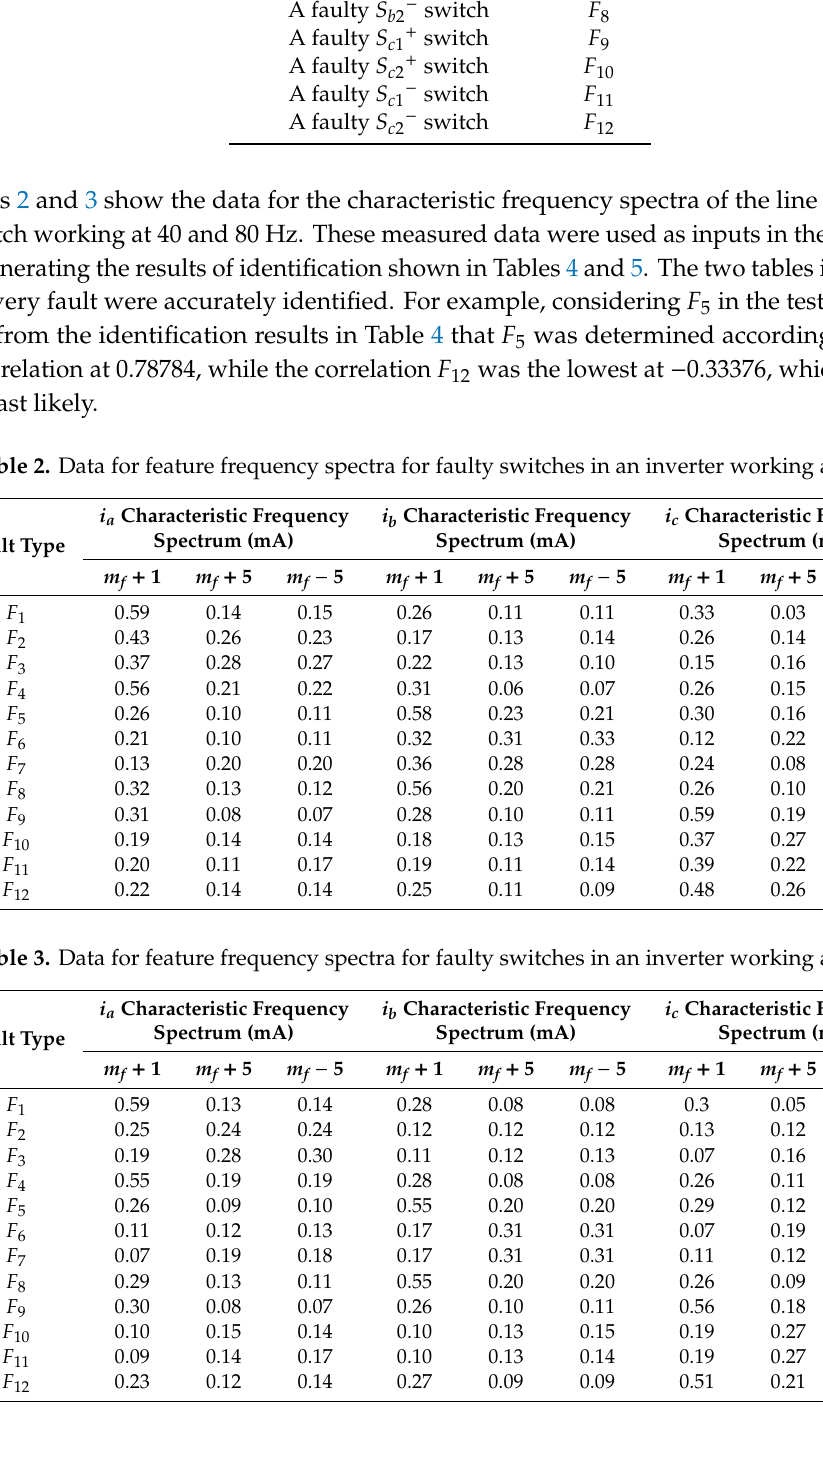
Table 2. Data for feature frequency spectra for faulty switches in an inverter working at 40 Hz.